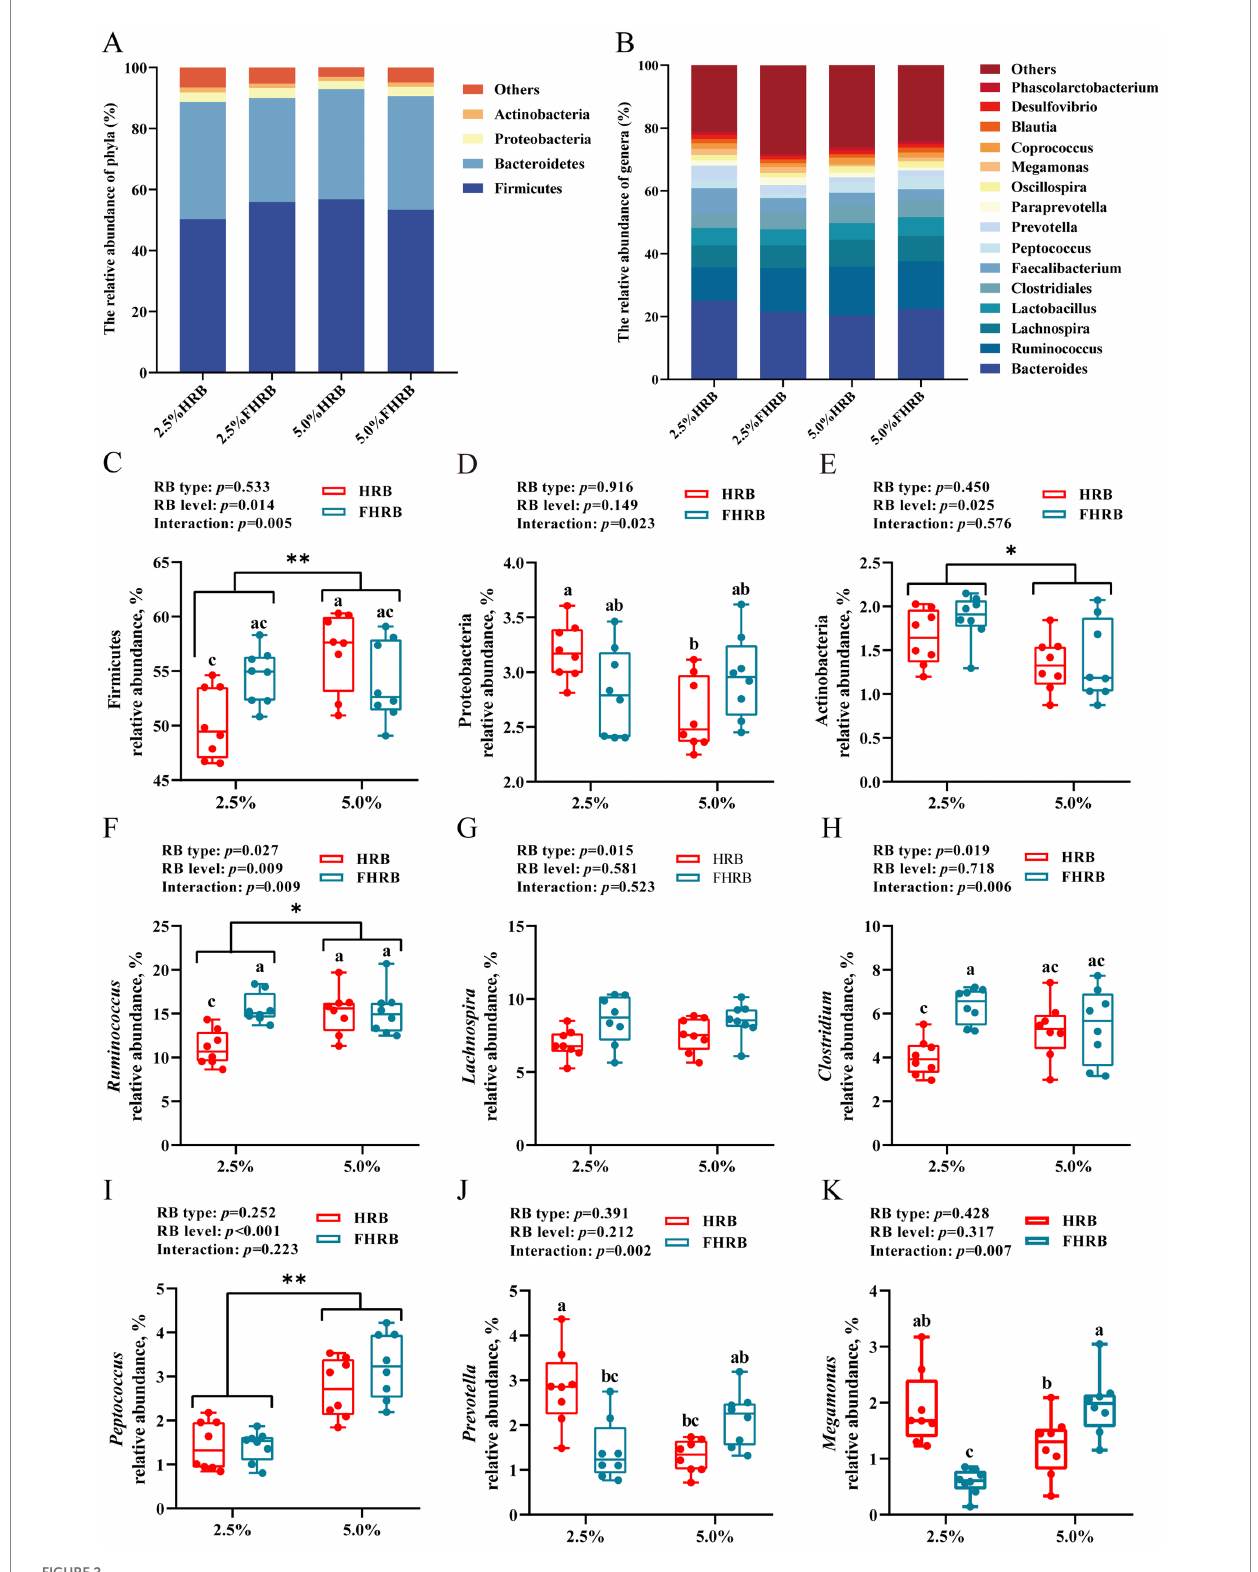
FIGURE 2 Effects of RB type and feeding level on the cecal microbiota of laying hens. (A) The most abundant (relative abundance >1%) phyla of cecal microbiota. (B) The most abundant (relative abundance >1%) genera of cecal microbiota. (C–K) The relative abundance of Firmicutes, Proteobacteria, Actinobacteria, Ruminococcus , Lachnospira , Clostridium , Peptococcus , Prevotella and Megamonas . * and ** indicate significant ( p < 0.05) and highly significant ( p < 0.01) differences at feeding level, respectively. Based on interaction p < 0.05, a–c values with different letters are significantly different at p <